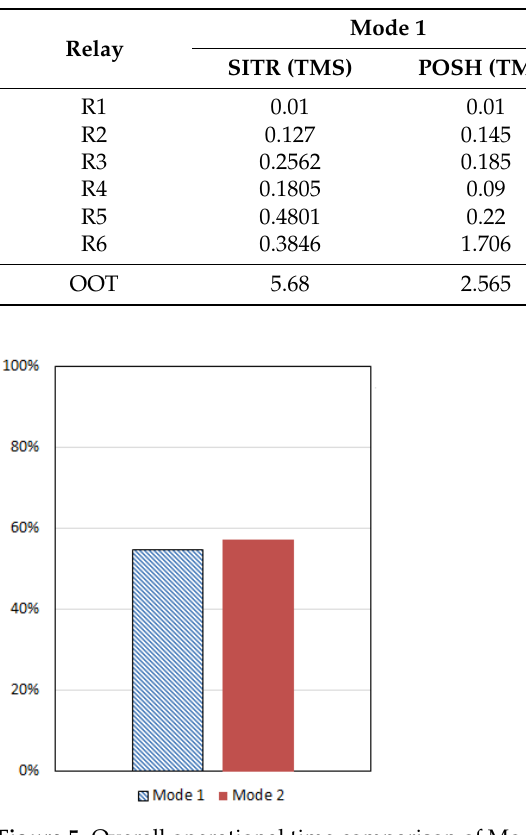
Table 5. The TMS and overall relays operational time (OOT) for all relays.